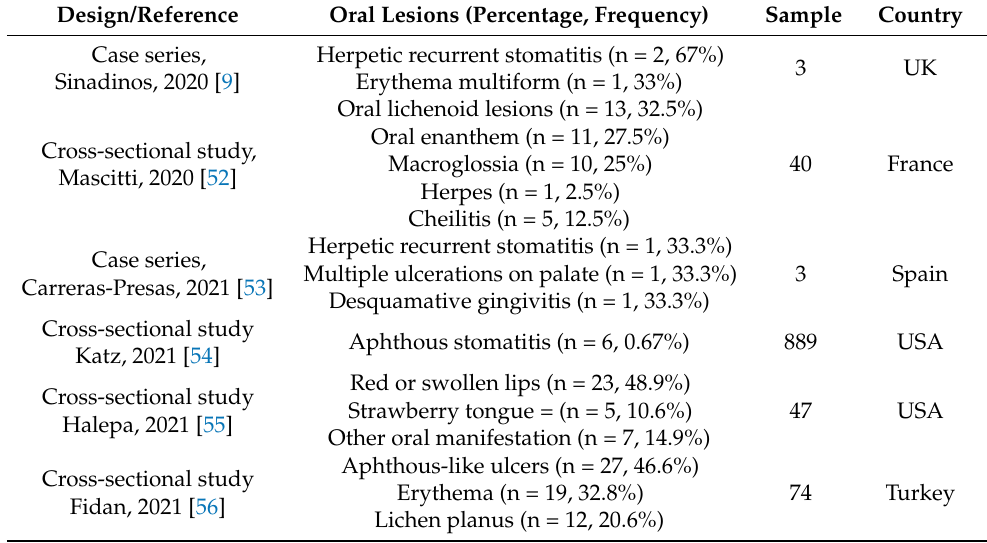
Table 1. Representative studies evaluating oral manifestations in patients with